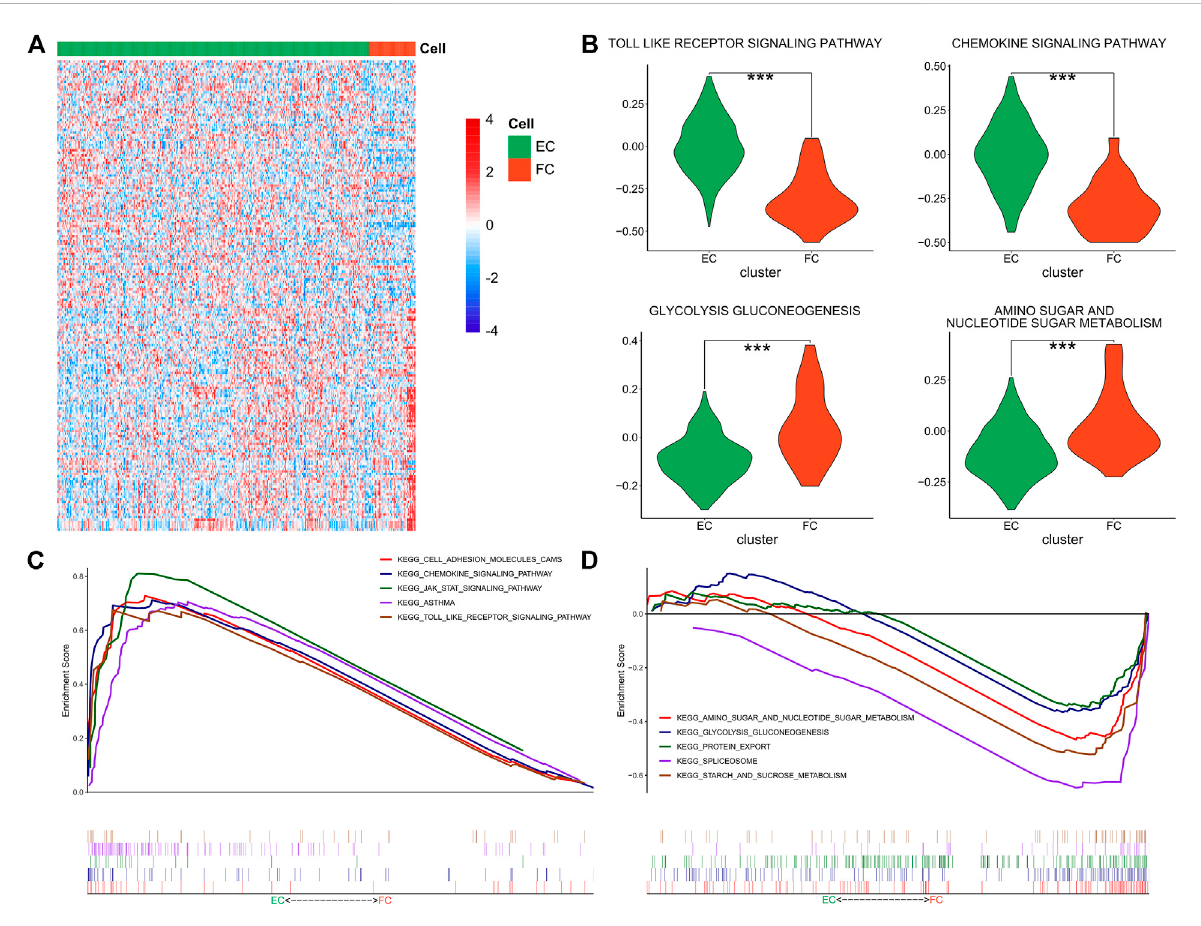
FIGURE 5 FunctionalenrichmentofECsandFCs. (A) TheHeatmapshowingtheGSVAenrichmentscoresofKEGGpathwaysinECsandFCs; (B) TheViolin plots showing the speci fi c GSVA results in ECs and FCs (*** p < 0.001); (C) GSEA results in ECs; (D) GSEA results in